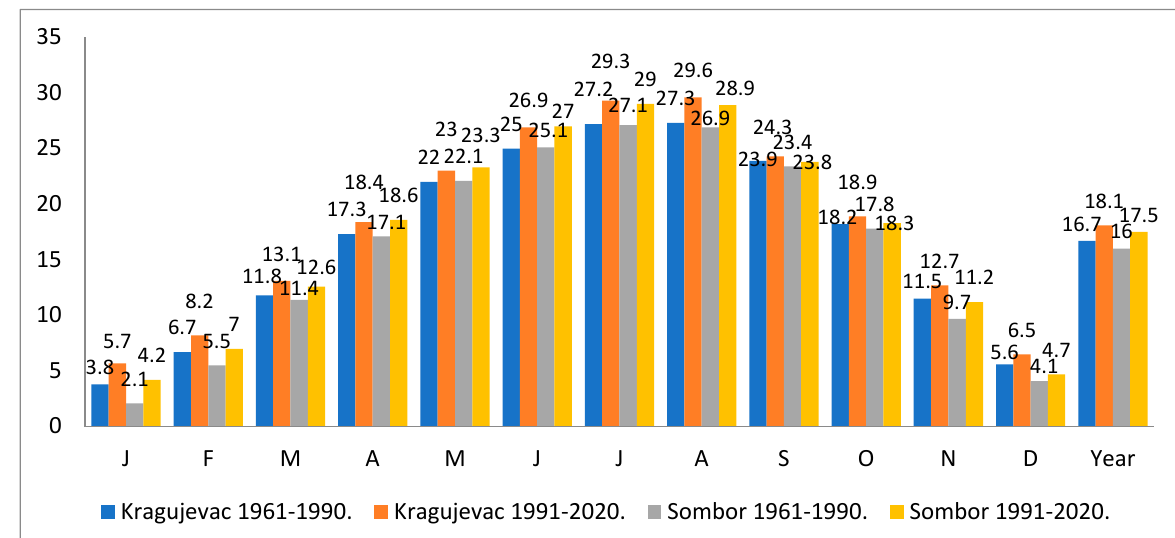
Figure 3. Maximum temperature for the meteorological stations Kragujevac and Sombor for a period of time 1961–1990 and 1991–2020. Source: RHMS-Meteorological yearbooks. Total amount of precipitation per year varied in both region and in both long term period. In first long-term period (1961–1990) the total amount of precipitation in Kragujevac was higher than in Sombor in 23 years, but in seven years precipitation values was higher in Sombor region than in Kragujevac. The lowest amount of precipitation was 401 mm in 1971 year and highest in 1974 in Sombor, while in Kragujevac during the first period the lowest